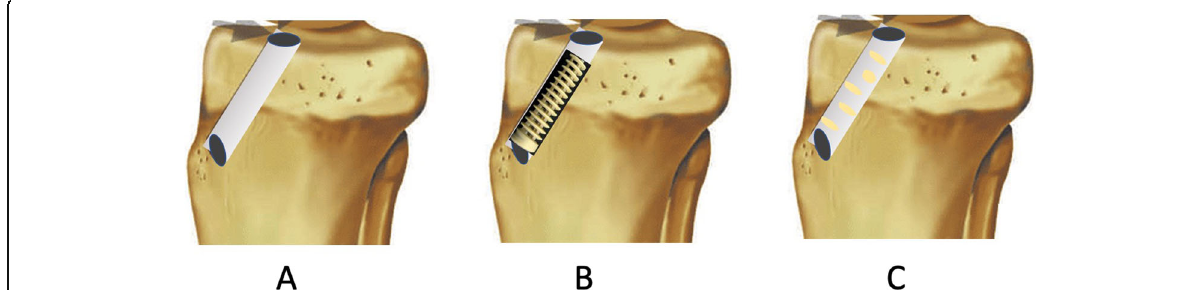
Fig. 3 A graphically illustration of the three tibial volumens that are determined for CT evaluation of bone ingrowth into the Healicoil screws. a : Volumen of the tibial tunnel in the location of the Healicoil screw. b : Volume of the PEEK material of the Healicoil screw. c : Volumen of the new bone formation in the areas of screw voids. Bone ingrowth is determined as New bone volume C/Void volumen a – b